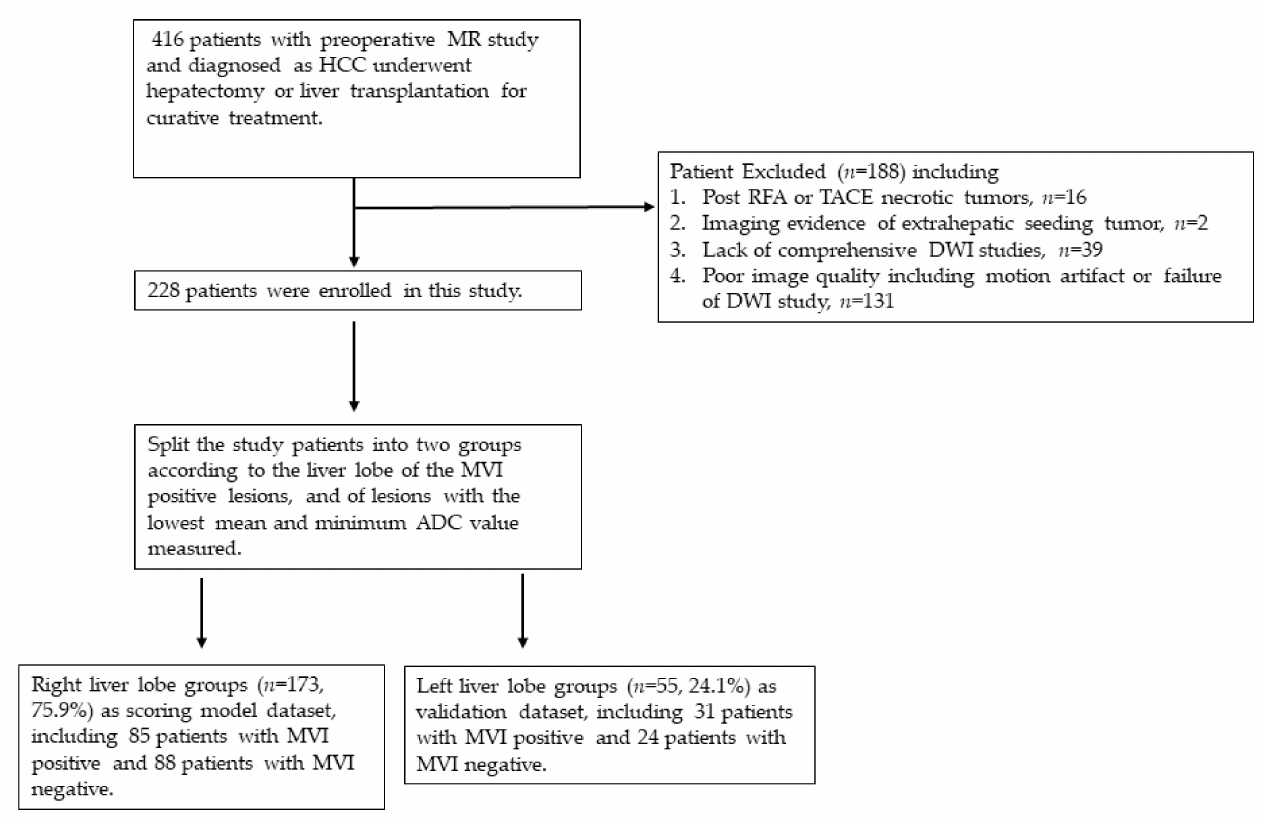
Figure 1. Flow chart of patient